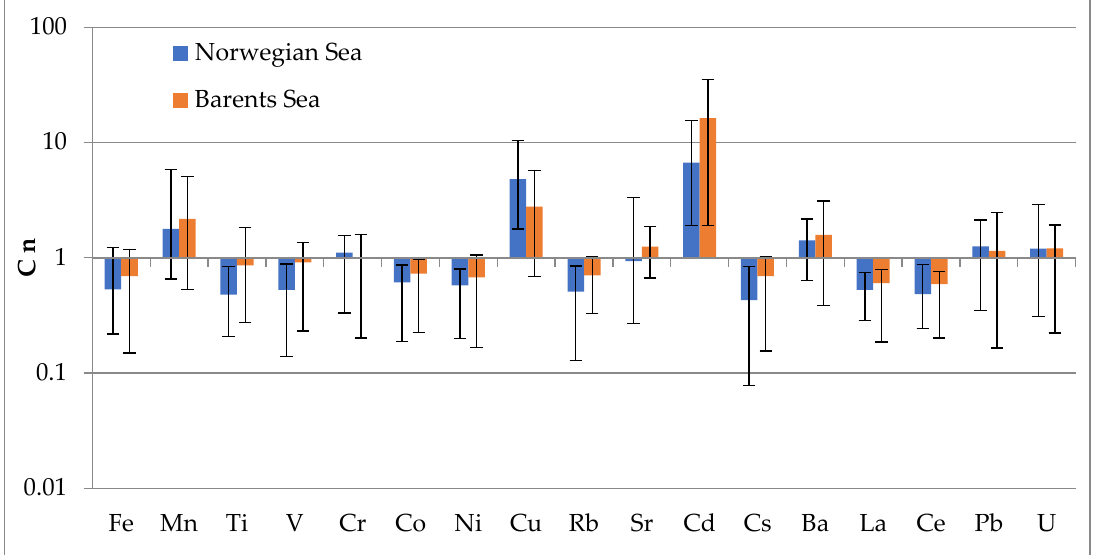
Figure 9. Average content of elements in SPM of BBL normalized to the composition of FLSM (C n ) and the range of variability of minimum and maximum values of C n .